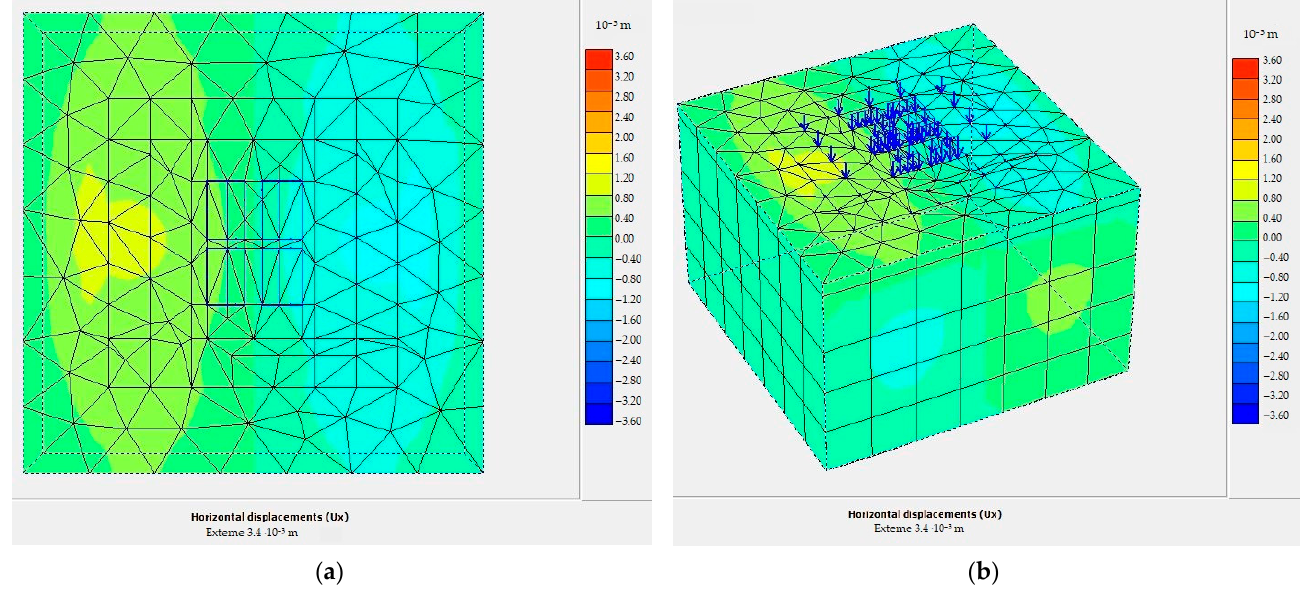
Figure 16. Horizontal displacement in the X-direction: ( a ) view of the surface of the raft; ( b ) volumetric model.